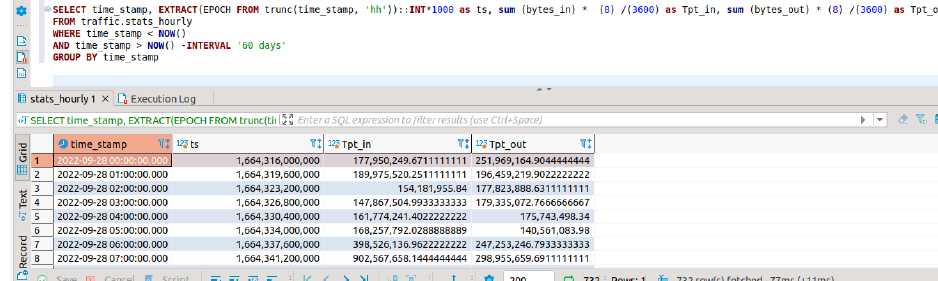
Figure 3. The subscriber